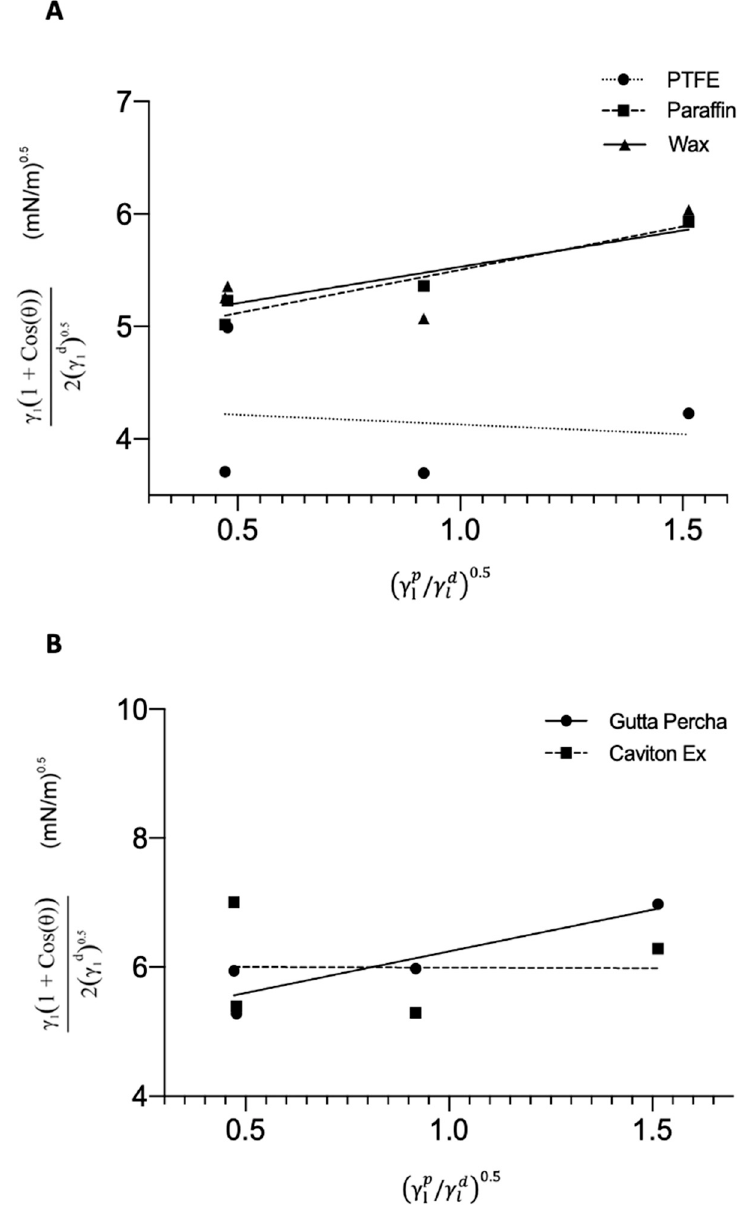
Figure 4. ( A ) Plot of the four liquids against PTFE, PF, and wax. The lines represent the best linear fit to the plotted point, respective to their material. The linear equation was used to solve for m and b to determine the SFE of the respective materials. ( B ) Plot of the four liquids against gutta percha and caviton ex. The lines represent the best linear fit to the plotted point, respective to their material. The linear equation was used to solve for m and b to determine the SFE of the respective materials.